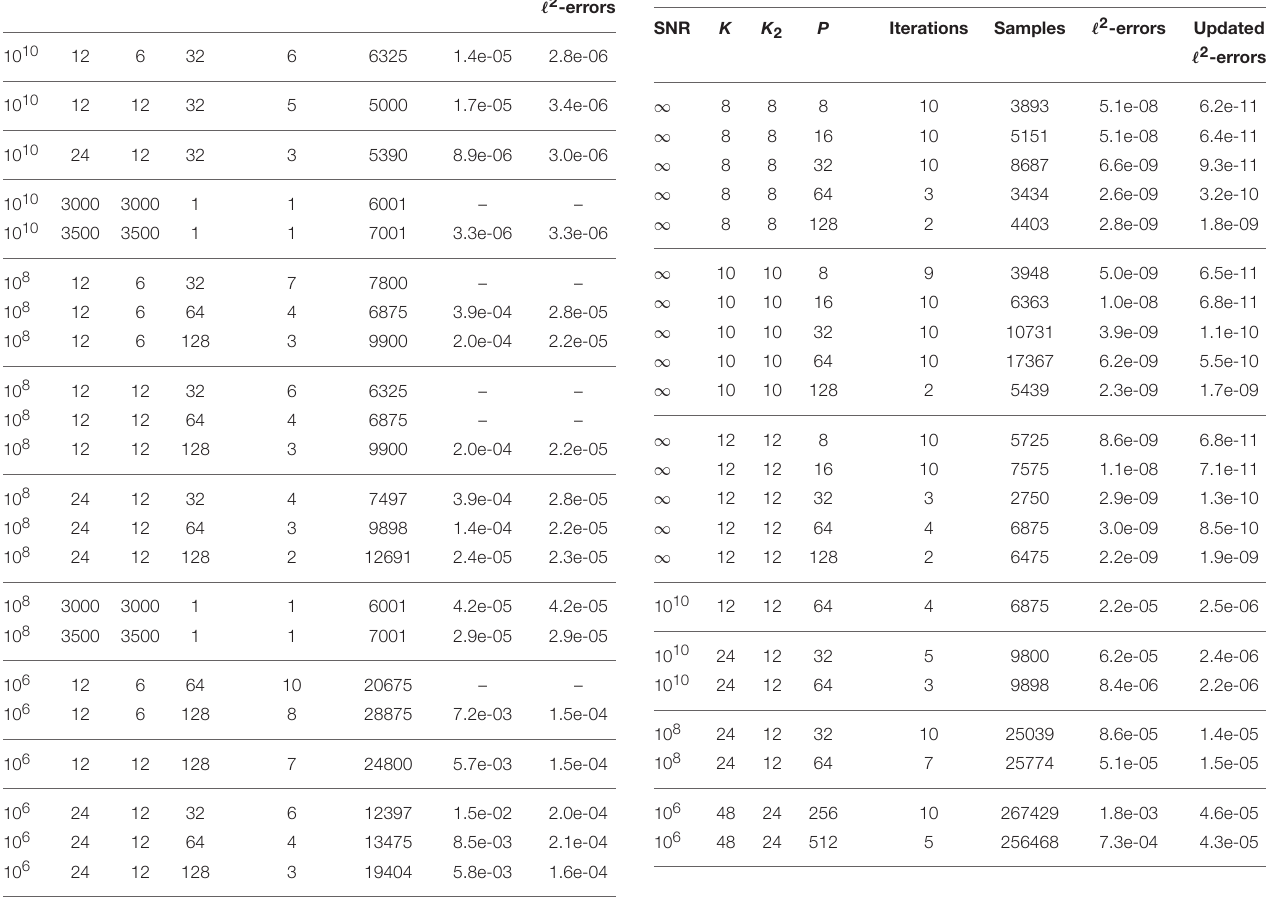
TABLE 8 | Results of the modified Algorithm 3.2 via ESPRIT with sparsity M = 256 , frequency vectors within six-dimensional hyperbolic cross index set Ŵ = { k ∈ Z 6 :